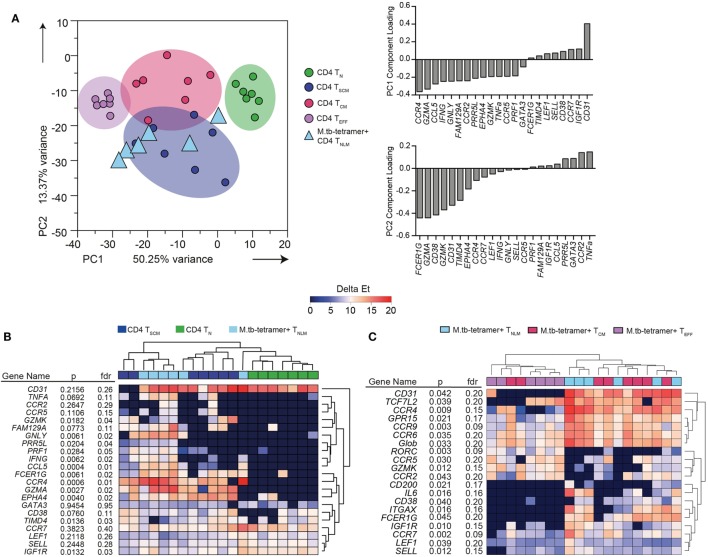
Transcriptional profile of Mycobacterium tuberculosis (M. tb)-specific TSCM. Expression of 96 genes was measured by microfluidic qRT-PCR on bulk or M. tb-tetramer+ CD4+ T cells expressing a naïve (TN, CD45RA+ CCR7+ CD27+ CD95−, labeled as naïve-like memory TNLM for M. tb-tetramer+), TSCM (CD45RA+ CCR7+ CD27+ CD95+, bulk CD4+ cells only), TCM (CD45RA− CCR7+ CD27+), or TEFF (CD45RA− CCR7−) phenotype, sorted from M. tb-infected adults (n = 7). Analyses shown in this figure were built on transcripts (22 mRNA) that were differentially expressed [Kruskal–Wallis H test p < 0.05 and false discovery rate (FDR) < 0.05] between bulk CD4+ TN, TSCM, TCM, and TEFF cells. (A) Principal component analysis (PCA) of sorted bulk TN (green), TSCM (indigo), TCM (magenta), and TEFF (purple). PCA loadings—PC1 and PC2—defined on bulk CD4+ subsets were applied to M. tb-tetramer+ TNLM (light blue triangles) CD4+ T cells. (B) Unsupervised heat map of 22 transcripts differentially expressed between bulk TN, TSCM, TCM, and TEFF subsets. Bulk TN, TSCM, and M. tb-tetramer+ TNLM represented as green, indigo, and light blue, respectively. Gene expression (GE) is reported as delta Et values [40 − threshold cycle (Ct) values]. (C) Supervised heat map of 20 transcripts differentially expressed (Kruskal–Wallis H test p < 0.05 and FDR < 0.2) between M. tb-tetramer+ TNLM (light blue), TCM (magenta), and TEFF (purple) CD4 T cell subsets. GE is reported as delta Et values (40 − Ct values).